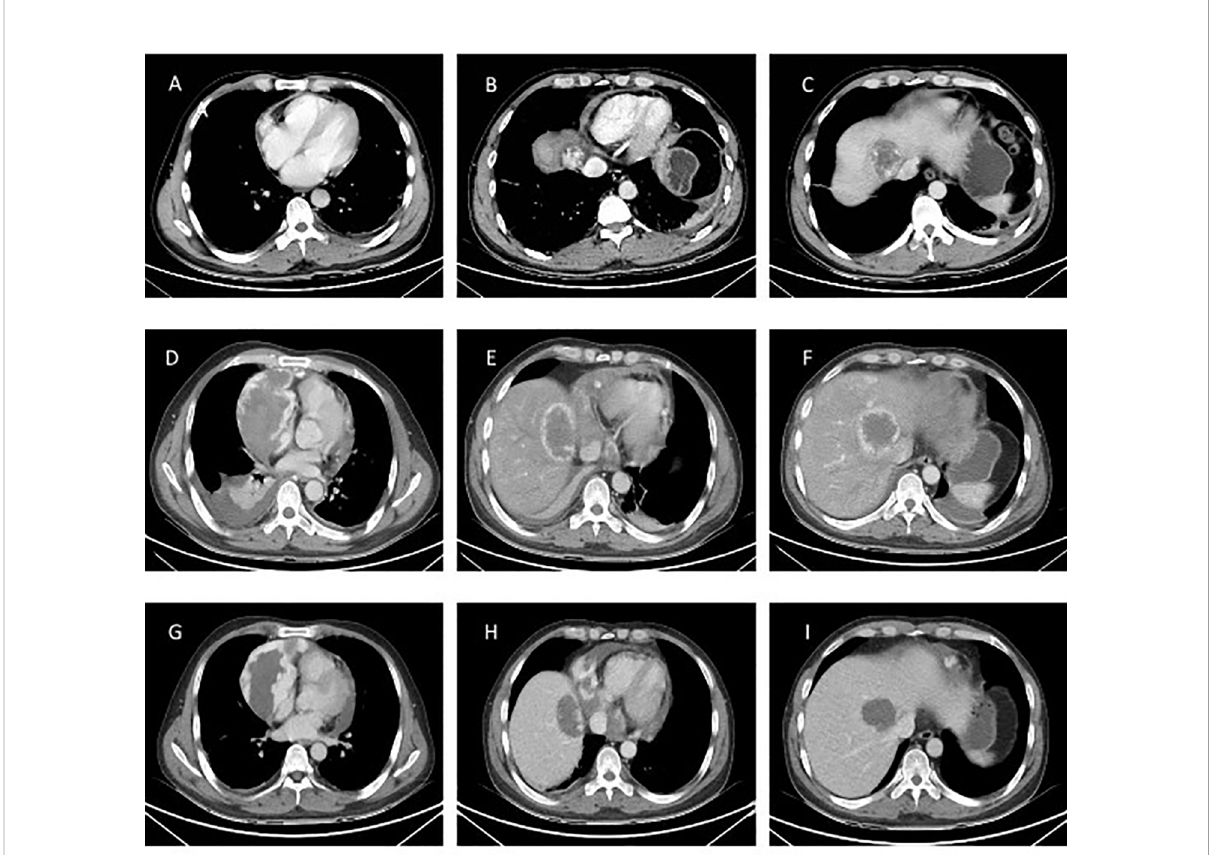
FIGURE 3 CT examination of the patient. (A-C) Patient ’ s initial CT image in March 2020. Space-occupying lesions in the right atrium, liver segment S8, pericardium; (D-F) CT images at the time of the patient ’ s readmission in May 2020. The right atrium and liver lesion were found to be signi fi cantly larger than before, as well as pericardial effusion, right pleural effusion and incomplete right lower lung distension were detected; (G-I) Ef fi cacy evaluation after 1 cycle of chemotherapy with stable disease in June